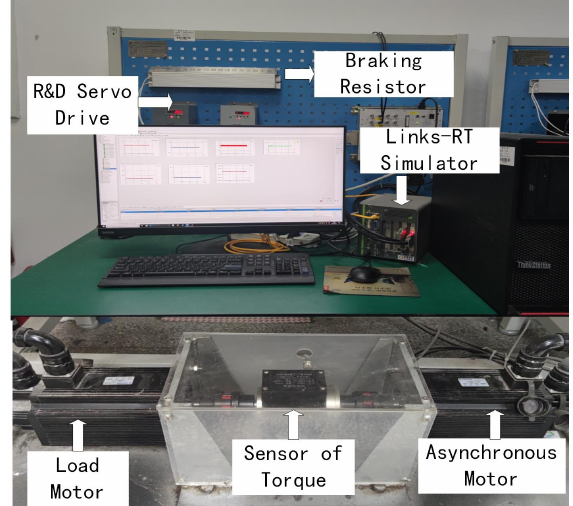
Figure 4. Experimental